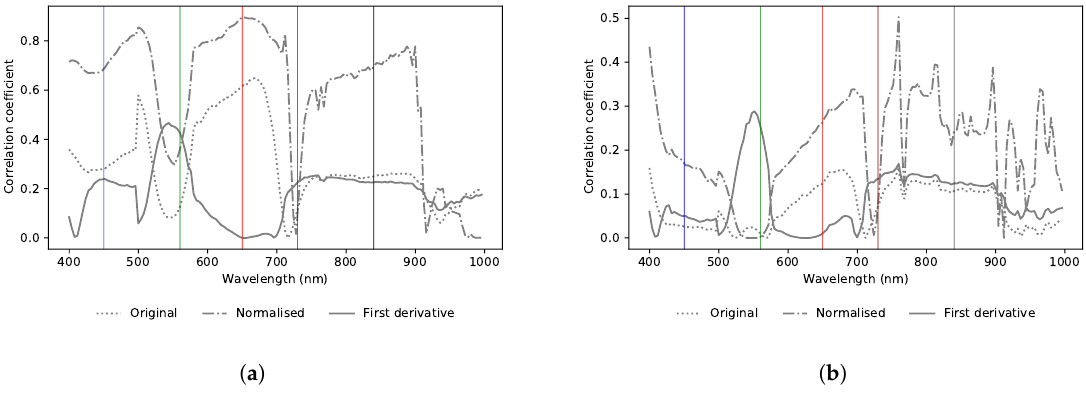
Figure 8. Correlograms of both acid detergent fibre ( a ) and crude protein ( b ) with; 1. Original SR uav spectra, 2. Normalised SR uav and 3. the first derivative of the normalised SR uav spectra. Table 6. Best linear regression models of both acid detergent fibre and crude protein for each spectral feature and data transformation including the raw spectral